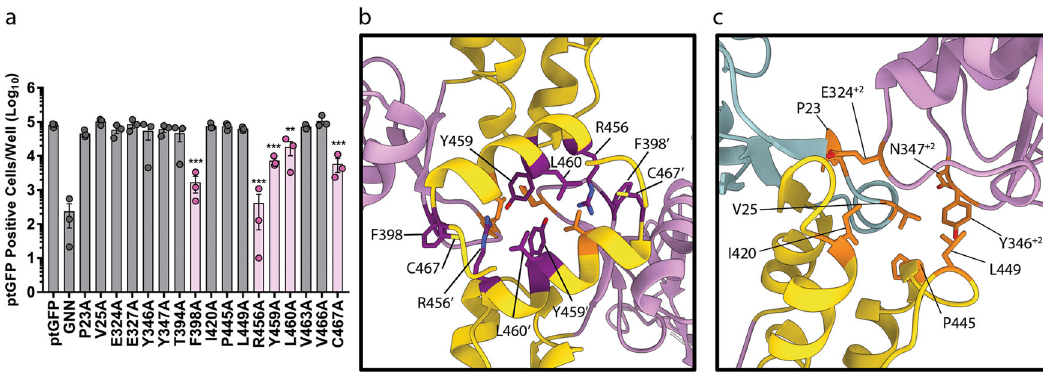
Fig. 7 Replication of 3D pol mutants. Intramolecular contact residues were identi fi ed and were mutated to alanine within the 3D-encoding region of ptGFP- expressing subgenomic replicon. a Replicon RNA was transfected into BHK-21 cells and replication determined by measuring the levels of GFP expression in comparison to the level of translation (GNN). Residues that signi fi cantly reduced the level of GFP expression are highlighted in pink. b and c Location of the amino acid residues that were mutated in this analysis, those that are coloured orange did not signi fi cantly affect replicon ef fi ciency, while those that are coloured dark magenta signi fi cantly reduced the levels of GFP expression and were located at the modelled 3D pol dimerisation interface only (PDB: